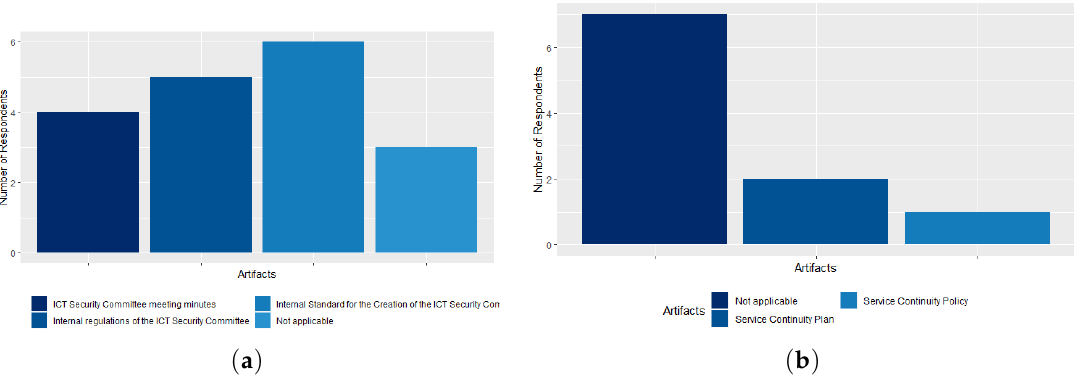
Figure 17. ( a ) The ICT Security Committee process artifacts; ( b ) the ICT Services Continuity Management process